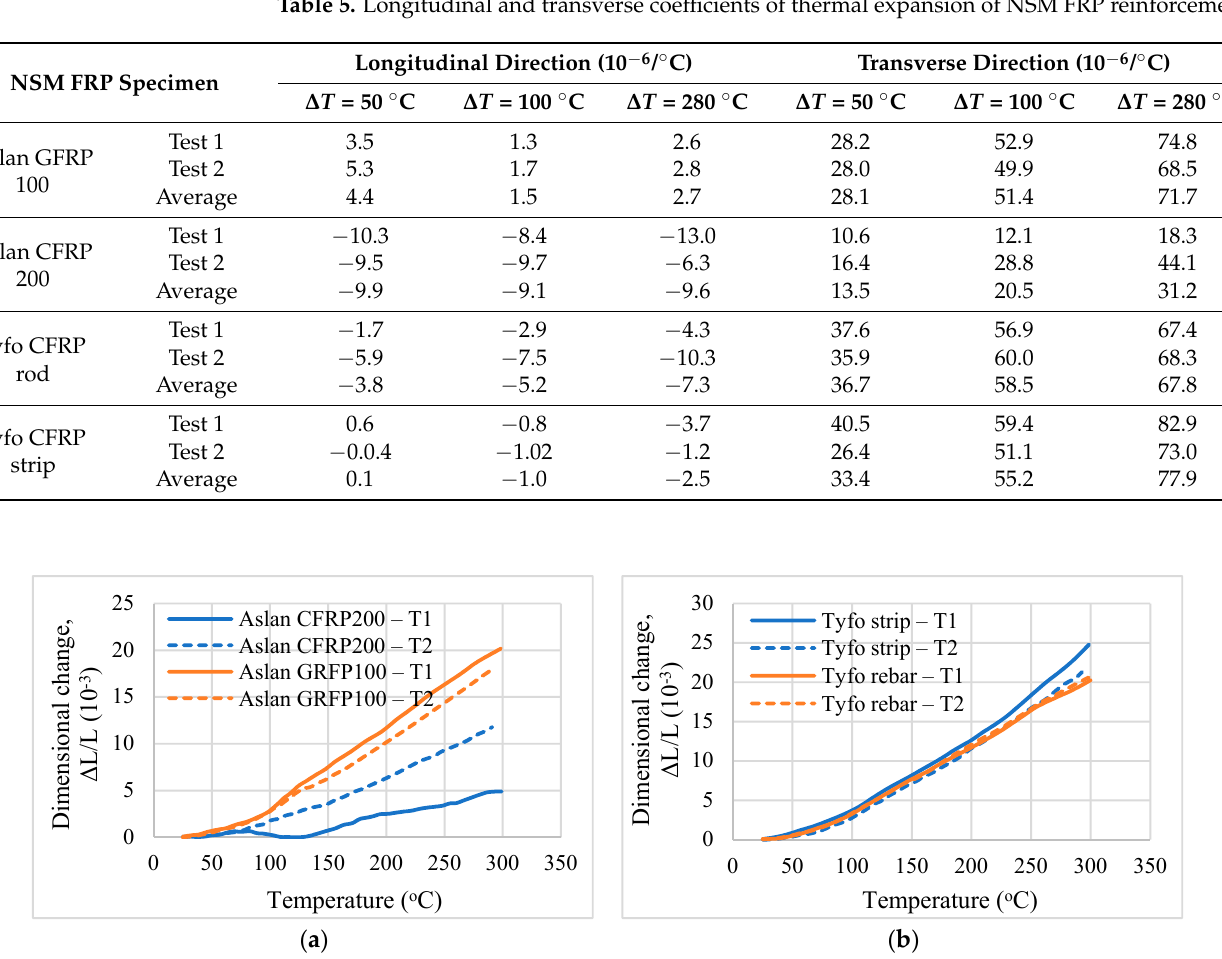
Table 5. Longitudinal and transverse coefficients of thermal expansion of NSM FRP reinforcement.